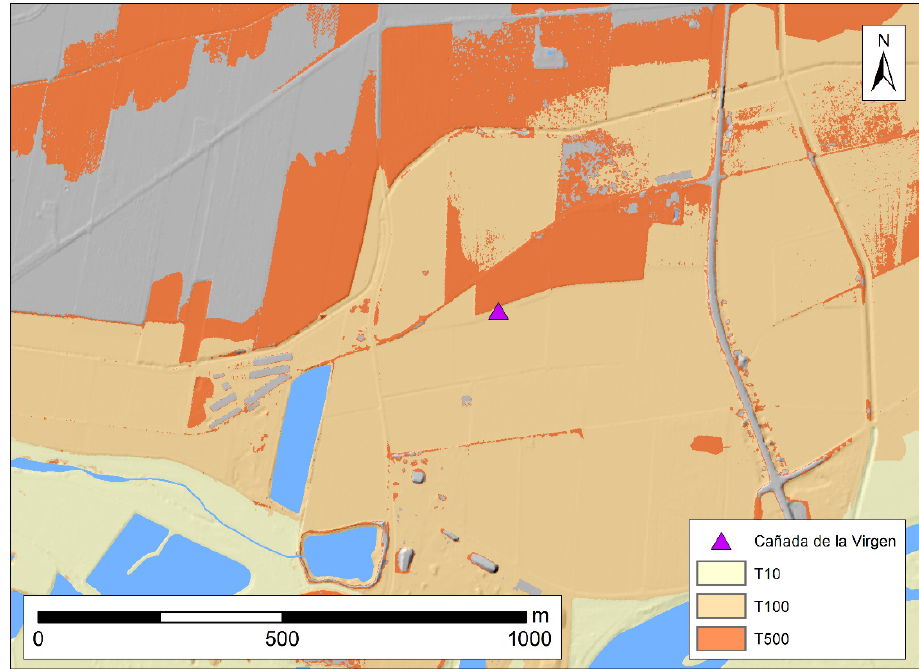
Figure 18. Model obtained from the APSFR analysis of the area where the tumulus of Cañada la Virgen (Puebla de la Calzada, Badajoz, Spain) is located, showing the effect of events T100 and T500 on the site.